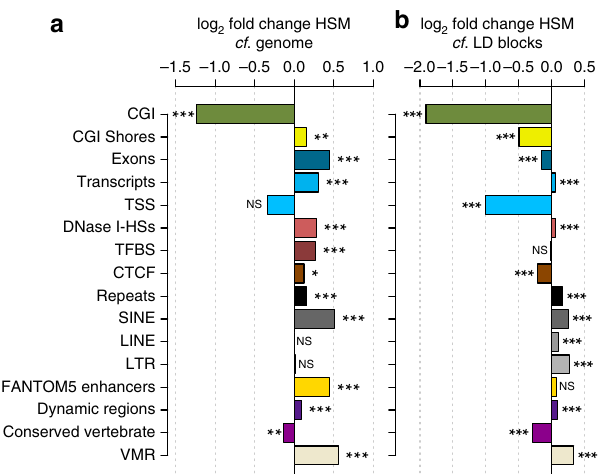
Fig. 7 Functional enrichment for HSM peaks. Functional enrichments log 2 fold change for HSM peaks in comparison to a genome and b GWAS LD block regions. These were compared with CpG Islands (CGI); CGI shores; exons; transcripts; transcription start sites (TSS); DNase-I hypersensitivity sites (DHS); transcription factor binding sites (TFBS); CTCF; repeats, including SINE, LINE and LTR subclasses; FANTOM5 enhancers; Dynamic DNA methylation regions; conserved vertebrate regions; variably methylated regions (VMRs). See ‘ Methods ’ for analysis and